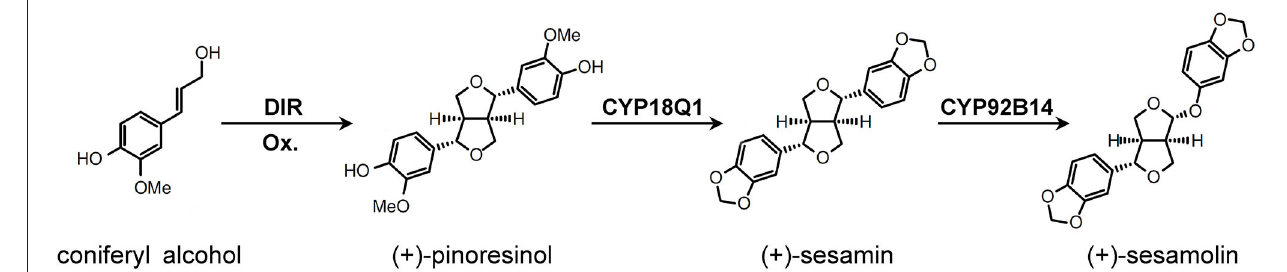
FIGURE 1 | The lignans biosynthetic pathway in Sesamum indicum . Figure was drawn based on Ono et al. (2006) and Murata et al. (2017). DIR, dirigent protein; Ox, oxidant.